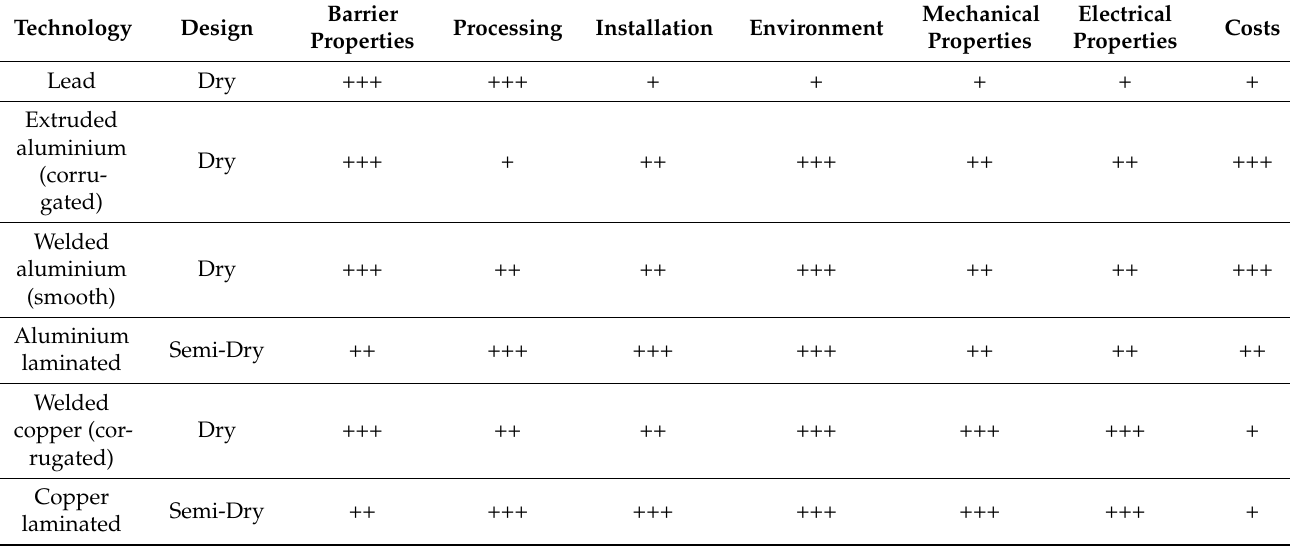
Table 4. Advantages and disadvantages of different radial water barriers in dry and semi-dry cable